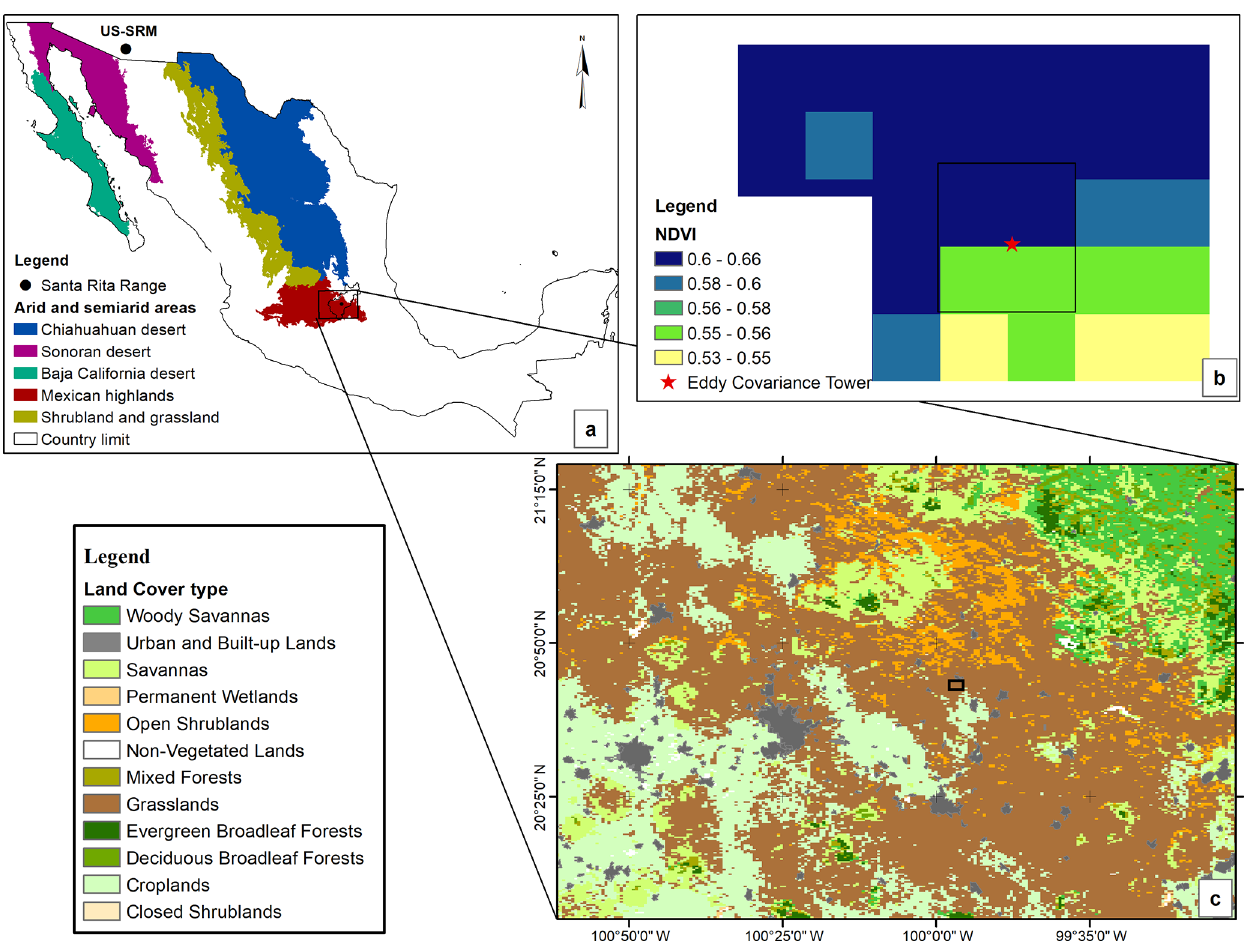
Figure 1. Localization and land use maps for the study site: (a) biogeographic arid and semiarid zones of southern North America relevant for the Bernal and Santa Rita sites; the black outline represents the state limit for Querétaro. (b) Heterogeneity of the normalized difference vegetation index (NDVI) surrounding the EC tower at Bernal during the peak of the growing season 2017 (DOY 257). (c) Land cover in the region of the Bernal site, according to the annual University of Maryland (UMD) classification (MCD12 MODIS